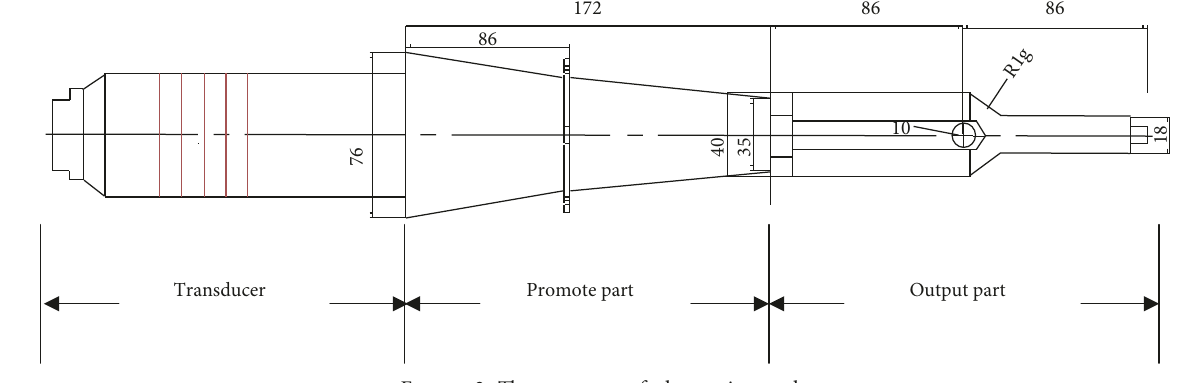
Figure 2: The structure of ultrasonic nozzle. Table 1: The properties of titanium alloy.